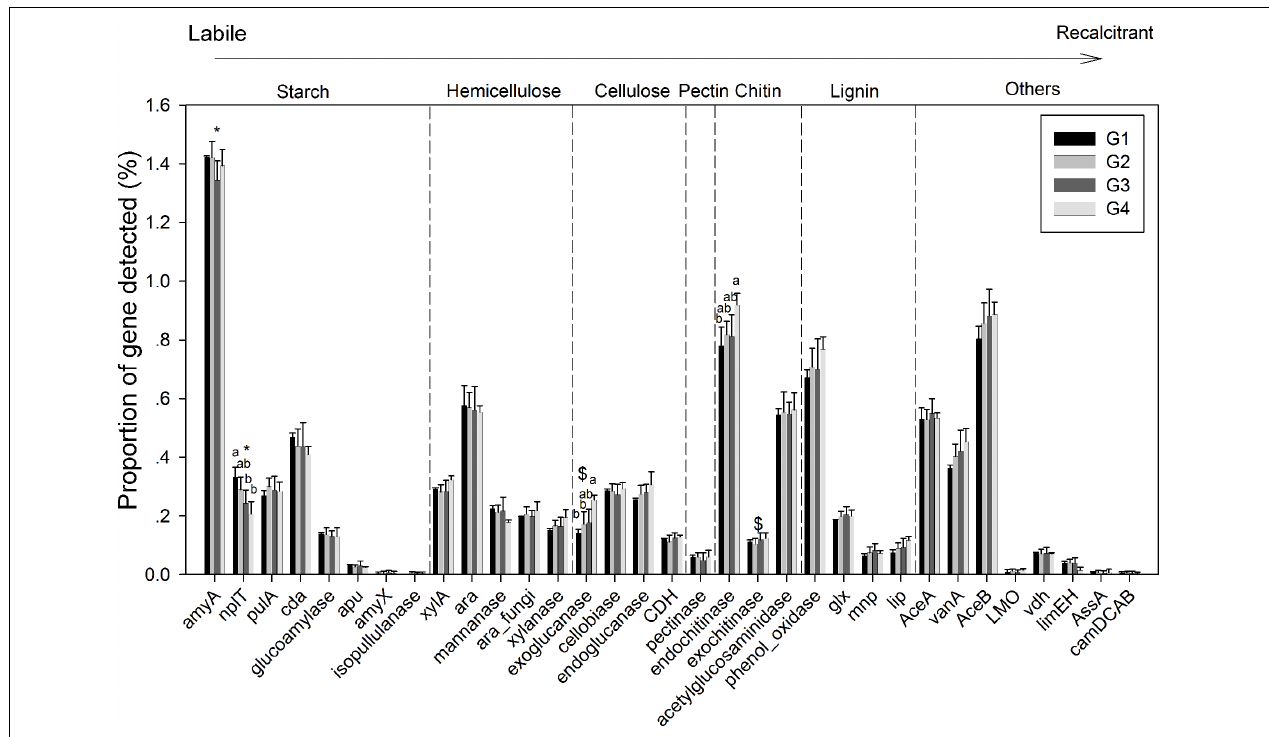
FIGURE 3 | Proportions of each gene within the C-degradation subcategory. Significant differences among/between the groups, and between surface and bottom samples, indicated by ANOVA with Tukey’s post hoc test are indicated by letters a and b, and by ∗ and $, separately, above the bars. The different letters indicate P < 0.05. ∗ Indicates higher mean proportion in surface samples, while $ indicates higher mean proportion in bottom samples with P <